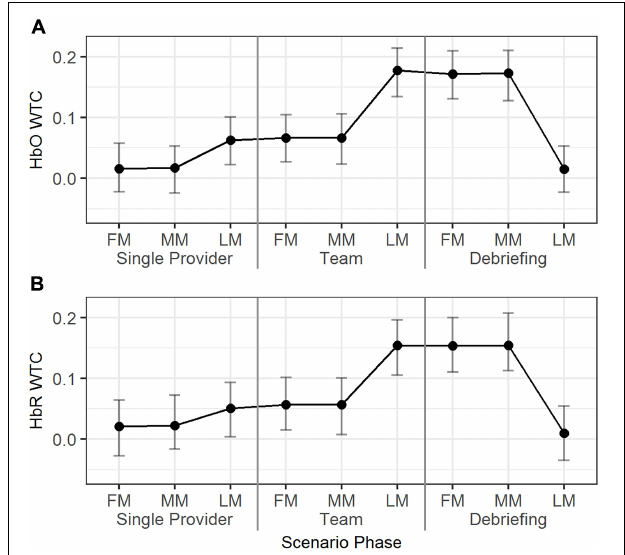
FIGURE 6 | The predicted means and 95% HDIs of the WTCs of HbO (A) and HbR (B) between the initial provider and the responder in a team at first/middle/last minutes (FM, MM, and LM) of the different scenario phases. The values of all the other variables were held at their